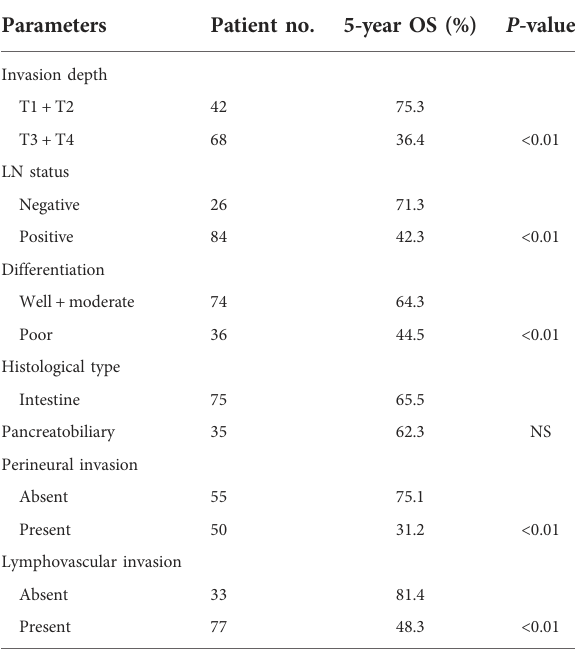
TABLE 4 Univariate analysis of pathological variables on survival in patients with ampullary